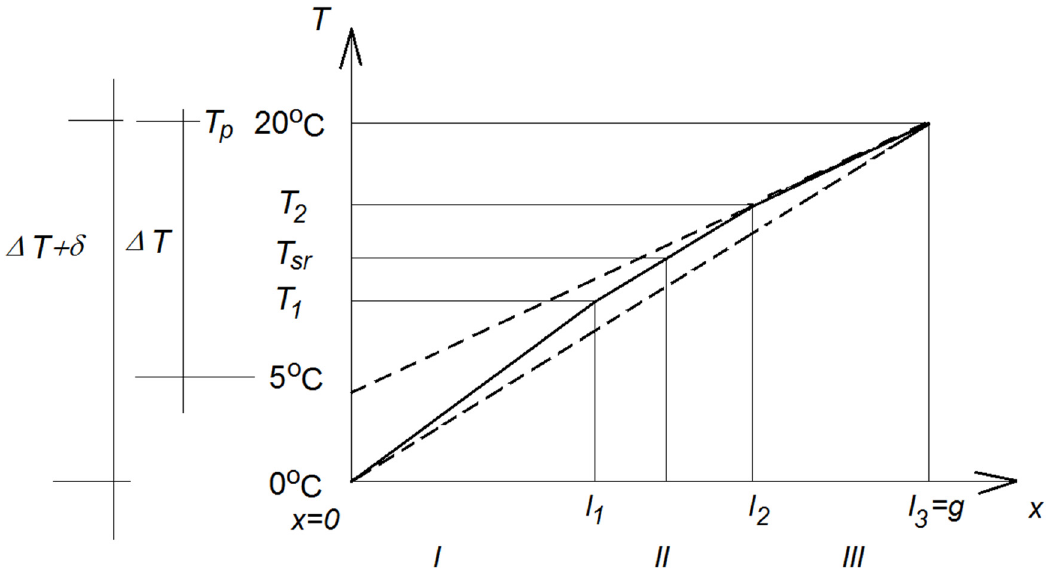
Figure 9. Geometry parameters and boundary conditions of the formulated problem.